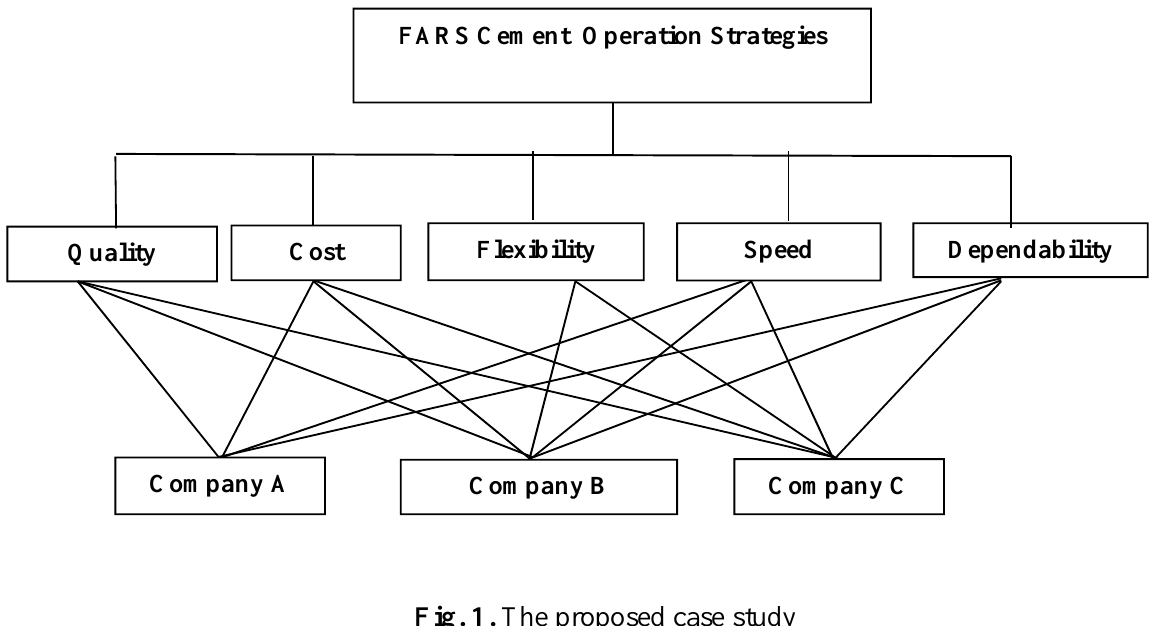
Fig. 1. The proposed case study